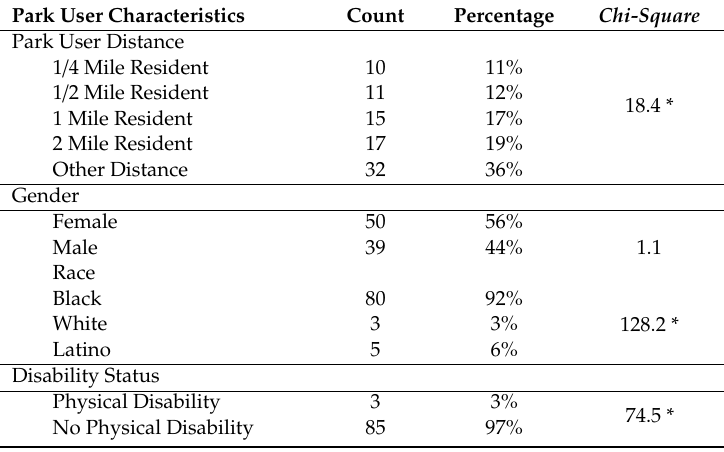
Table 2. Park User Demographic characteristics based on intercept interviews.